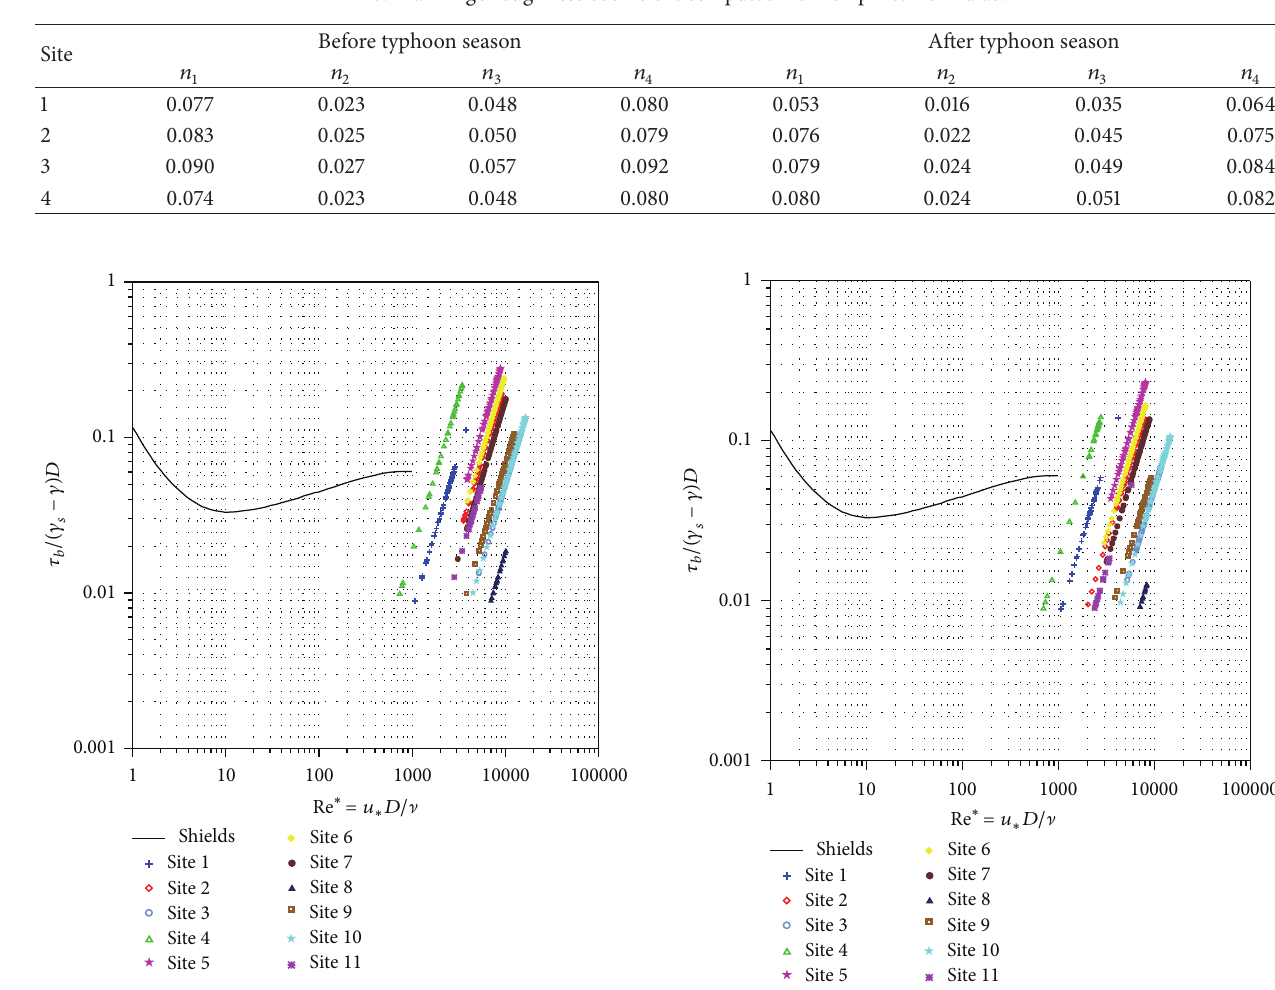
Figure 10: Shields diagram with data from all the sites using 10-year return period. ( 𝜏 𝑏 /(𝛾 𝑠 −𝛾)𝐷) in which, 𝜏 𝑏 is bed shear stress, 𝛾 𝑠 and 𝛾 are sediment and fluid densities, respectively, and 𝐷 is the grain size tobemovedmultipliedbyaccelerationduetogravity.Theparameter ( 𝑢 ∗ 𝐷/ ] ) represents the Reynolds number, in which 𝑢 ∗ is the shear velocity and ] is the kinematic viscosity.